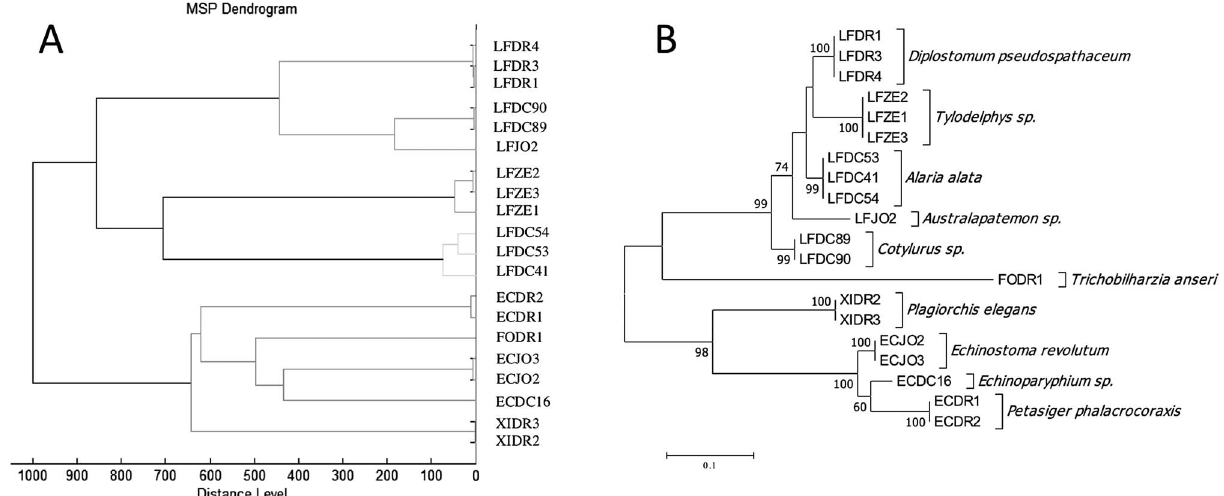
Figure 2. Panel A: Hierarchical clustering dendrogram of MALDI-TOF MSP, using the correlation distance measure and Ward algorithm. All the MSPs were included in the fi nal database. Panel B: Maximum likelihood tree of the D2 domain of the cercariae strains present in the MALDI-TOF spectral database.